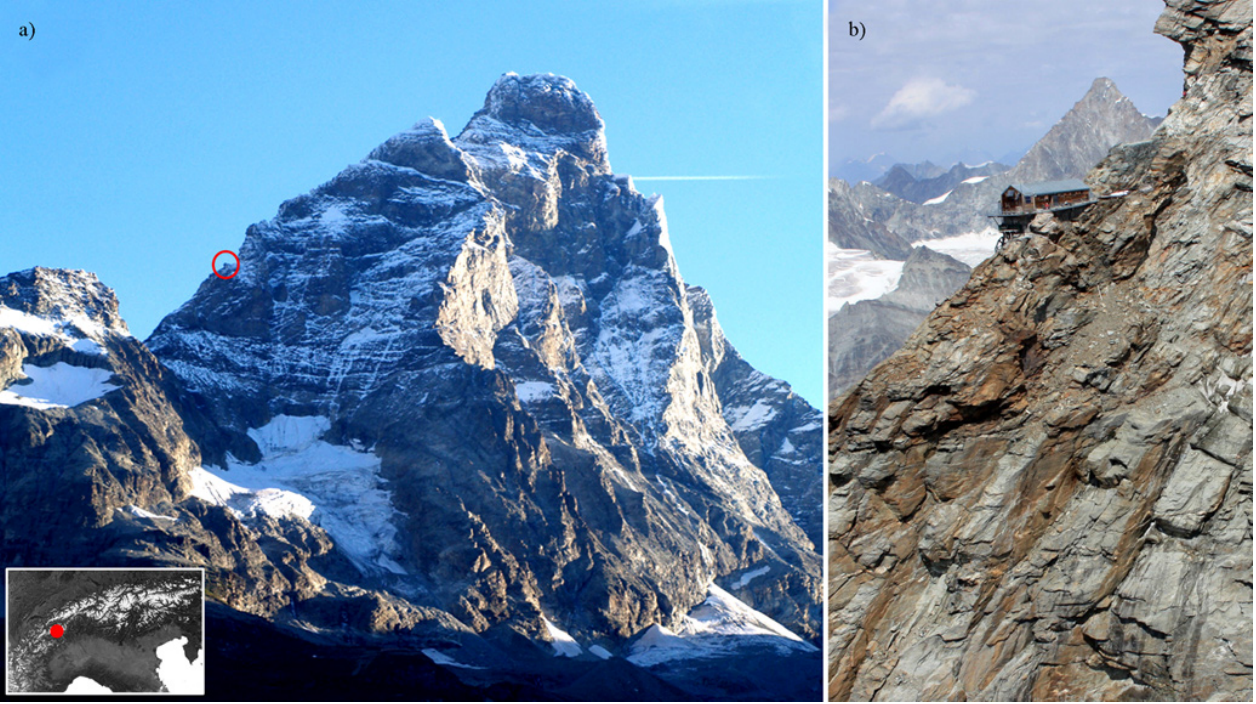
Fig. 1. Geographical context and location of the monitoring site: (a) the Matterhorn peak, the study site lies in the red circle; (b) detail of the J. A. Carrel